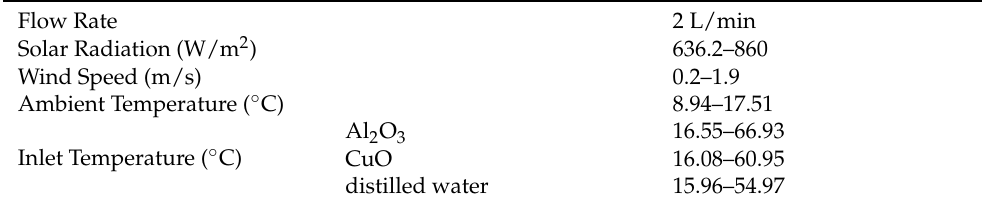
Table 2. The experimental conditions when the flow rate is 2 L/min.